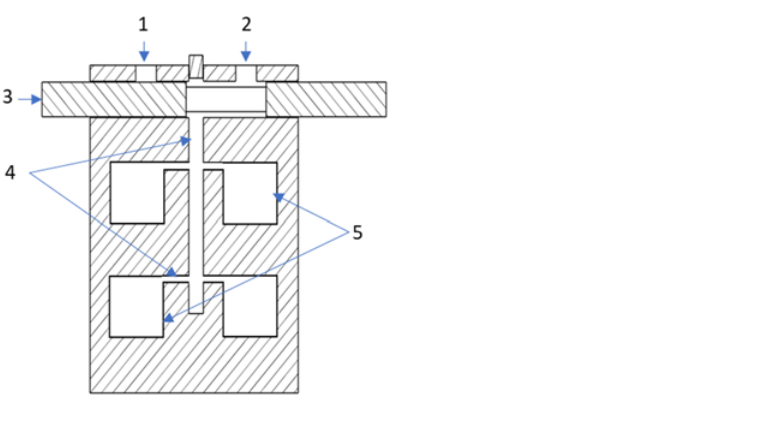
Figure 4. Three ‐ way valve. 1. The inlet of reference/cleaning gas, 2. The inlet of test gas, 3. Moving part of the three ‐ way valve, 4. Gas channels, 5. Sensor